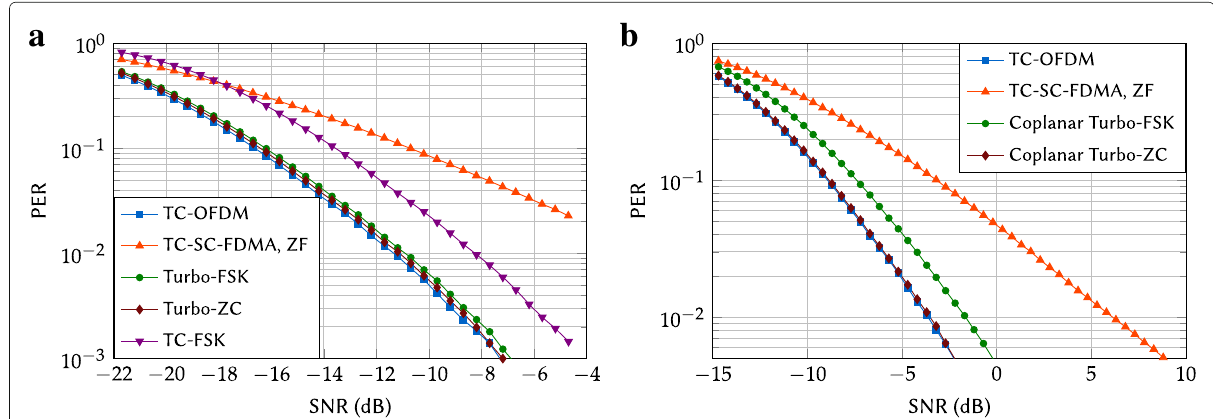
Fig. 5 Performance of the five compared solutions under static Rayleigh fading channel with ETU profile, for the first scenario ( a ) and for the second scenario ( b